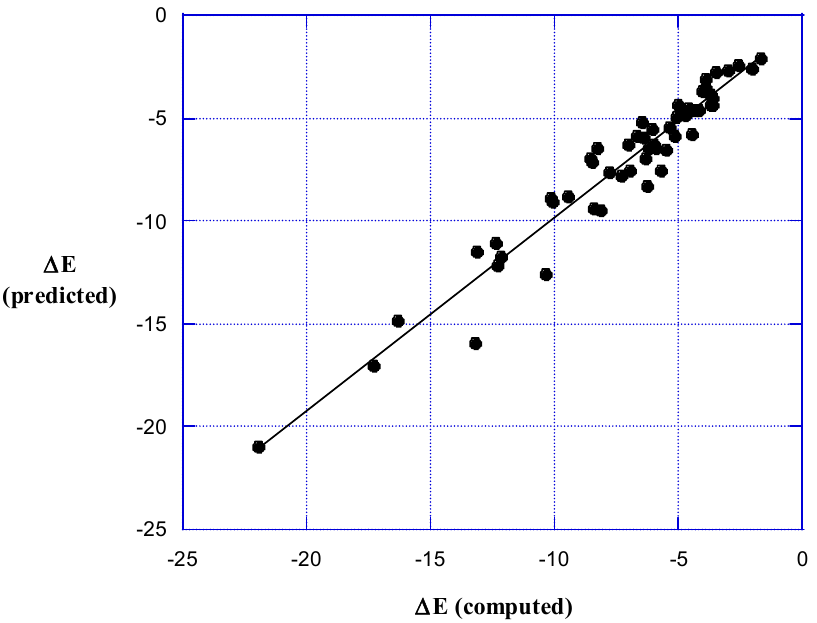
Figure 3. ∆ E predicted with Equation (4) plotted against the computed ∆ E, in kcal / mol, for the σ -hole Figure 3. Δ E predicted with Equation (4) plotted against the computed Δ E, in kcal/mol, for the σ -hole interactions in Table 1. R 2 = 0.938. interactions in Table 1. R 2 = 0.938.